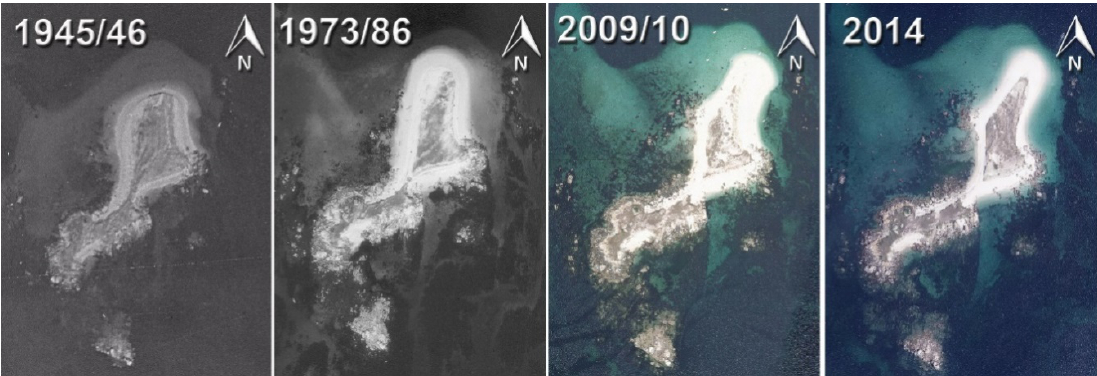
Figure 2. Aerial photographs from the island of Guidoiro Areoso, (1945–2014). Starting in the 1980s, sea level rise reduced the height of the dune on the northern portion by 1 m in height and has narrowed the beaches to the point that the island will soon split into two (Images taken from the Fototeca Digital del Instituto Geográfico Nacional IGN (2004–2018) under CC-BY 4.0 license . The second image from the left corresponds to a composite of theInterministerial flights taking place between November 1976 and July 1986).